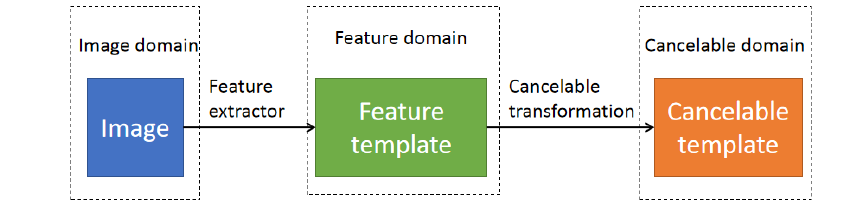
Figure 4. Cancellable biometric framework.